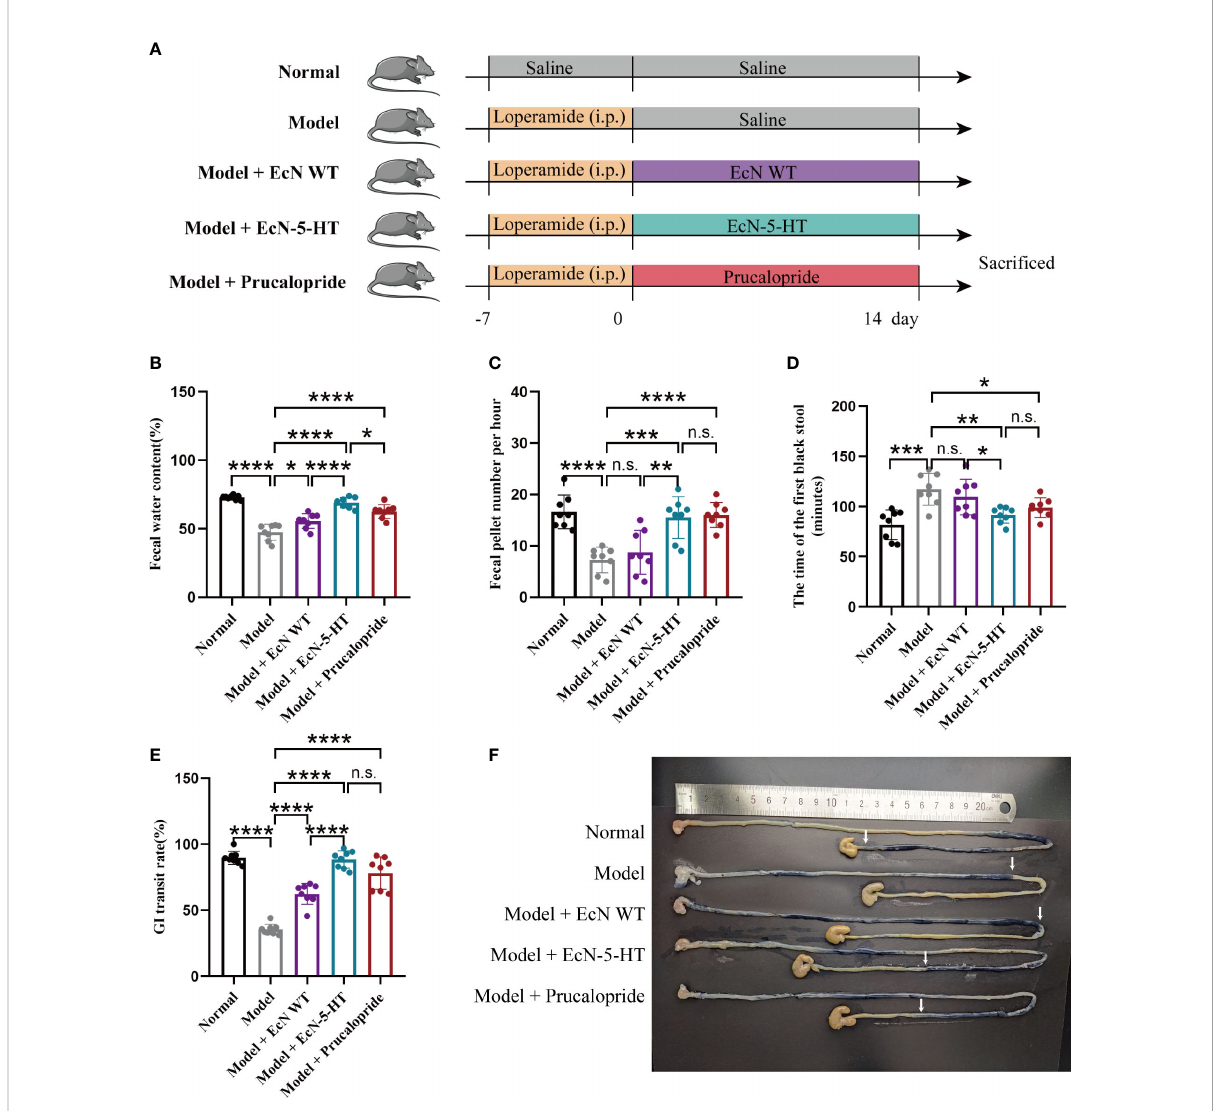
FIGURE 2 EcN-5-HT improved gastrointestinal motility in a loperamide ‐ induced constipation model. (A) Experimental setup. (B) Fecal water relative content. (C) Fecal pellet number per hour. (D) Time to fi rst black stool defecation. (E) GI transit. (F) Representative images of small intestine after treatment with activated carbon by gavage. Mean values ± SDs are presented, p values were calculated using unpaired t-test, *p < 0.05, **p < 0.01, ***p < 0.001 and ****p < 0.0001 n.s, not signi fi cant. Data are pooled from three independent experiments with n = 8 mice per